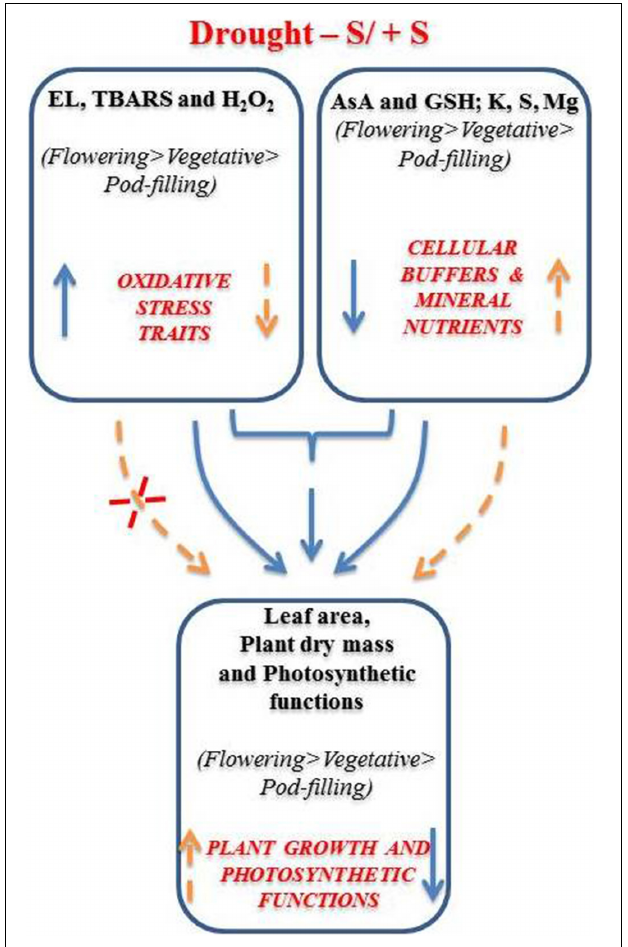
FIGURE 3 | Schematic representation of drought stress impacts and the role of sulfur (S) in mungbean ( Vigna radiata ) during its ontogeny. Complete and broken lines indicate respectively drought alone and drought + S conditions; whereas, increase and decrease have been indicated by the up and down arrows